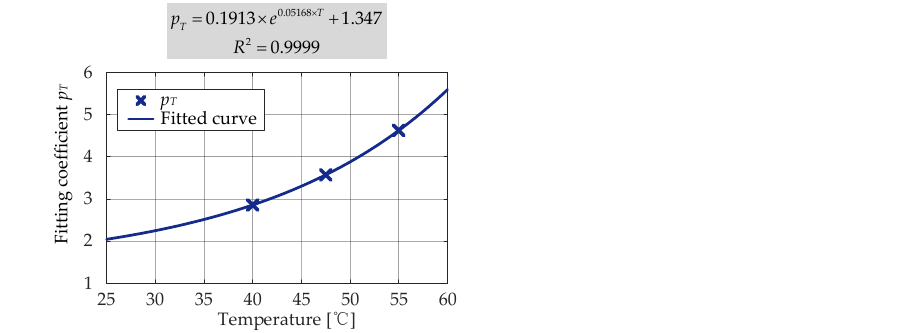
Figure 16. The exponential relationship between the curve fitting coefficients p T and the corresponding storage temperature T .